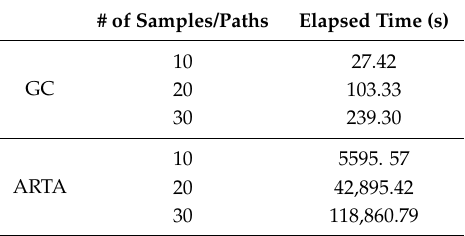
Table 6. Elapsed Time in